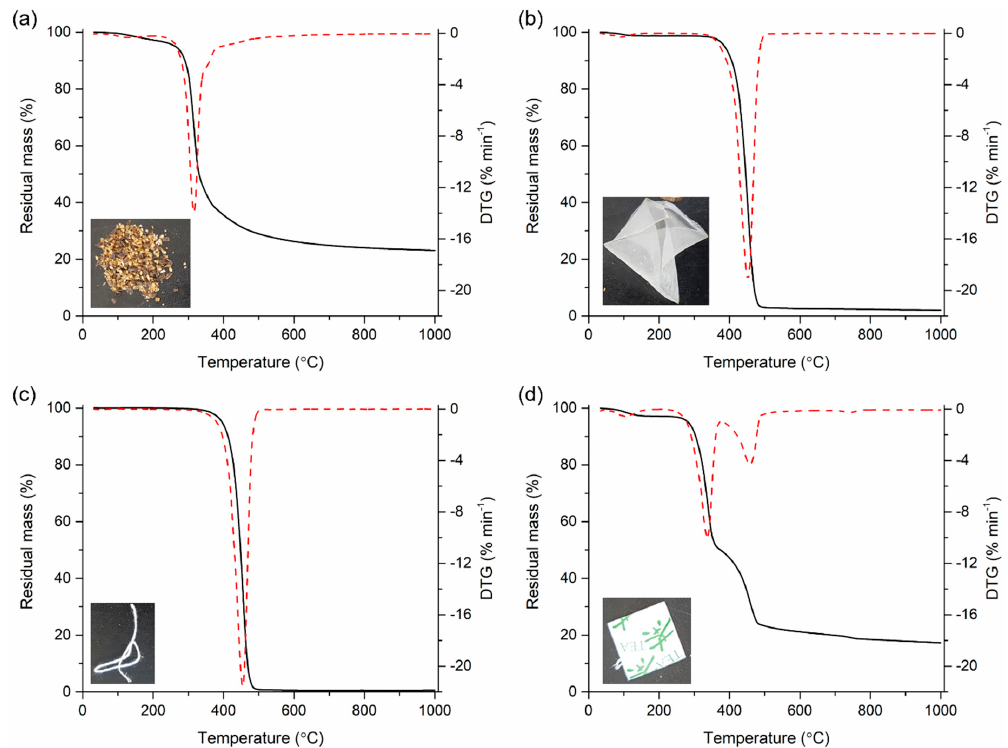
Figure 1. TG and DTG curves of components of the TBW: ( a ) biomass; ( b ) plastic bag; ( c ) thread; and ( d ) paper. Table 1. Results of proximate, ultimate, and composition analyses of the TBW. Composition